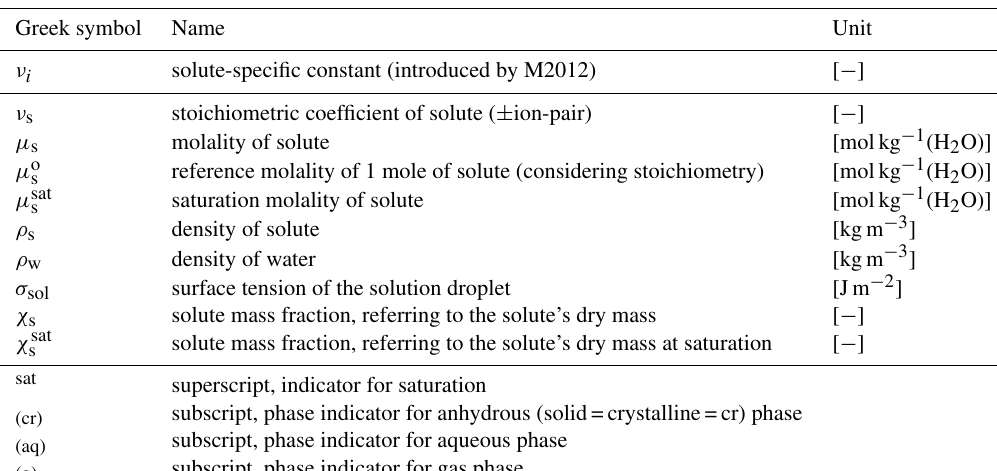
Table A2. List of greek symbols.